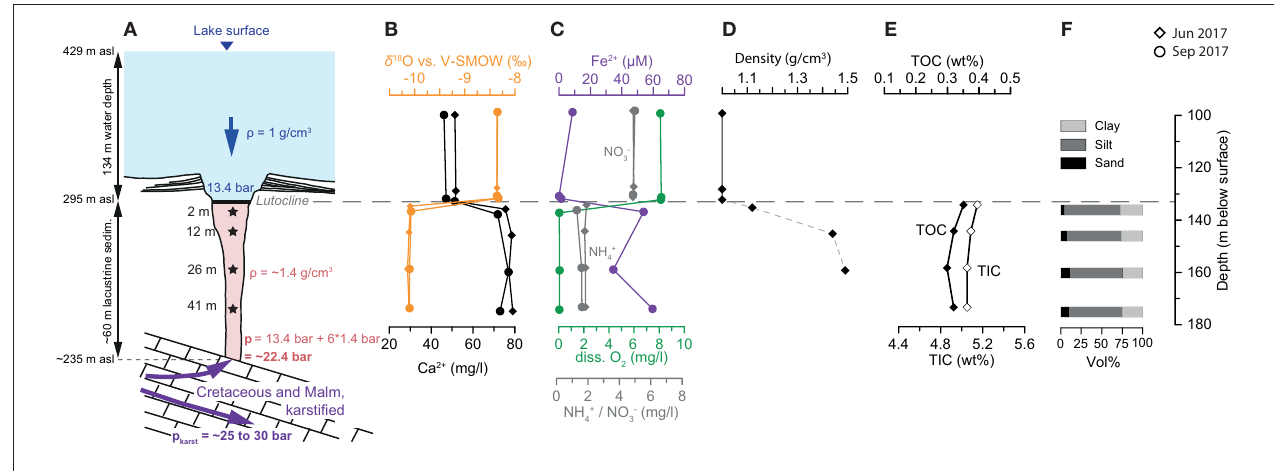
FIGURE 7 | (A) Conceptual model of the CB pockmark showing the chimney with a depth of ∼ 60m, the positions of the samples taken in the chimney and the (hypothesized) direct contact between the chimney and the Mesozoic units and thus the karst system. Also shown are estimations for the hydrostatic pressure at the base of the chimney and the hydraulic pressure in the karst system. (B) δ 18 O composition and Ca 2 + concentration in the lake water and in the pore water of the chimney mud; (C) concentrations of Fe 2 + , NO − 3 , NH + 4 and dissolved oxygen. (D) Density of the pockmark mud estimated via pressure data and exact depth control from the electrical winch. (E) TOC and TIC content in the particulate fraction of the pockmark mud. (F) Grain-size volume fractions of the pockmark mud.